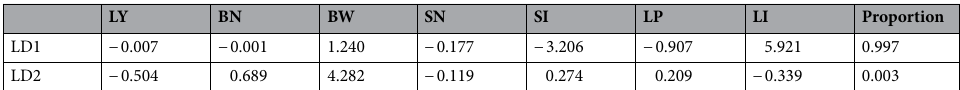
Table 6. Linear Discriminants of lint yield/plant (LY), boll number/plant (BN), boll weight (BW), seed number/boll (SN), seed index (SI), lint % (LP), and lint index